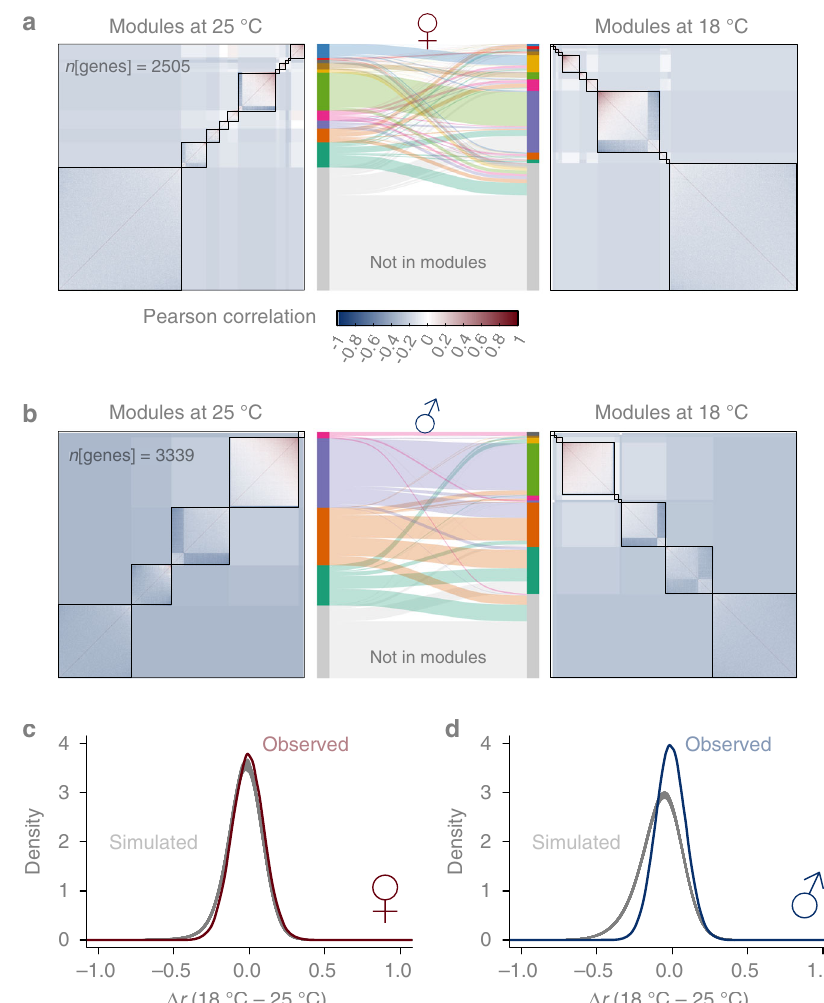
Fig. 5 Robust co-expression networks in the presence of plastic regulatory variation. Module preservation between 25 and 18 °C in females ( a ) and males ( b ). Density plots for Δ r between 18 and 25 °C where the gray lines are based on 1000 simulations while the darkcolored line is observed in females ( c ) and males ( d ). The test for signi fi cance was based on the variance of the distribution of Δ r . The null hypothesis was equal variance while the alternative hypothesis was smaller